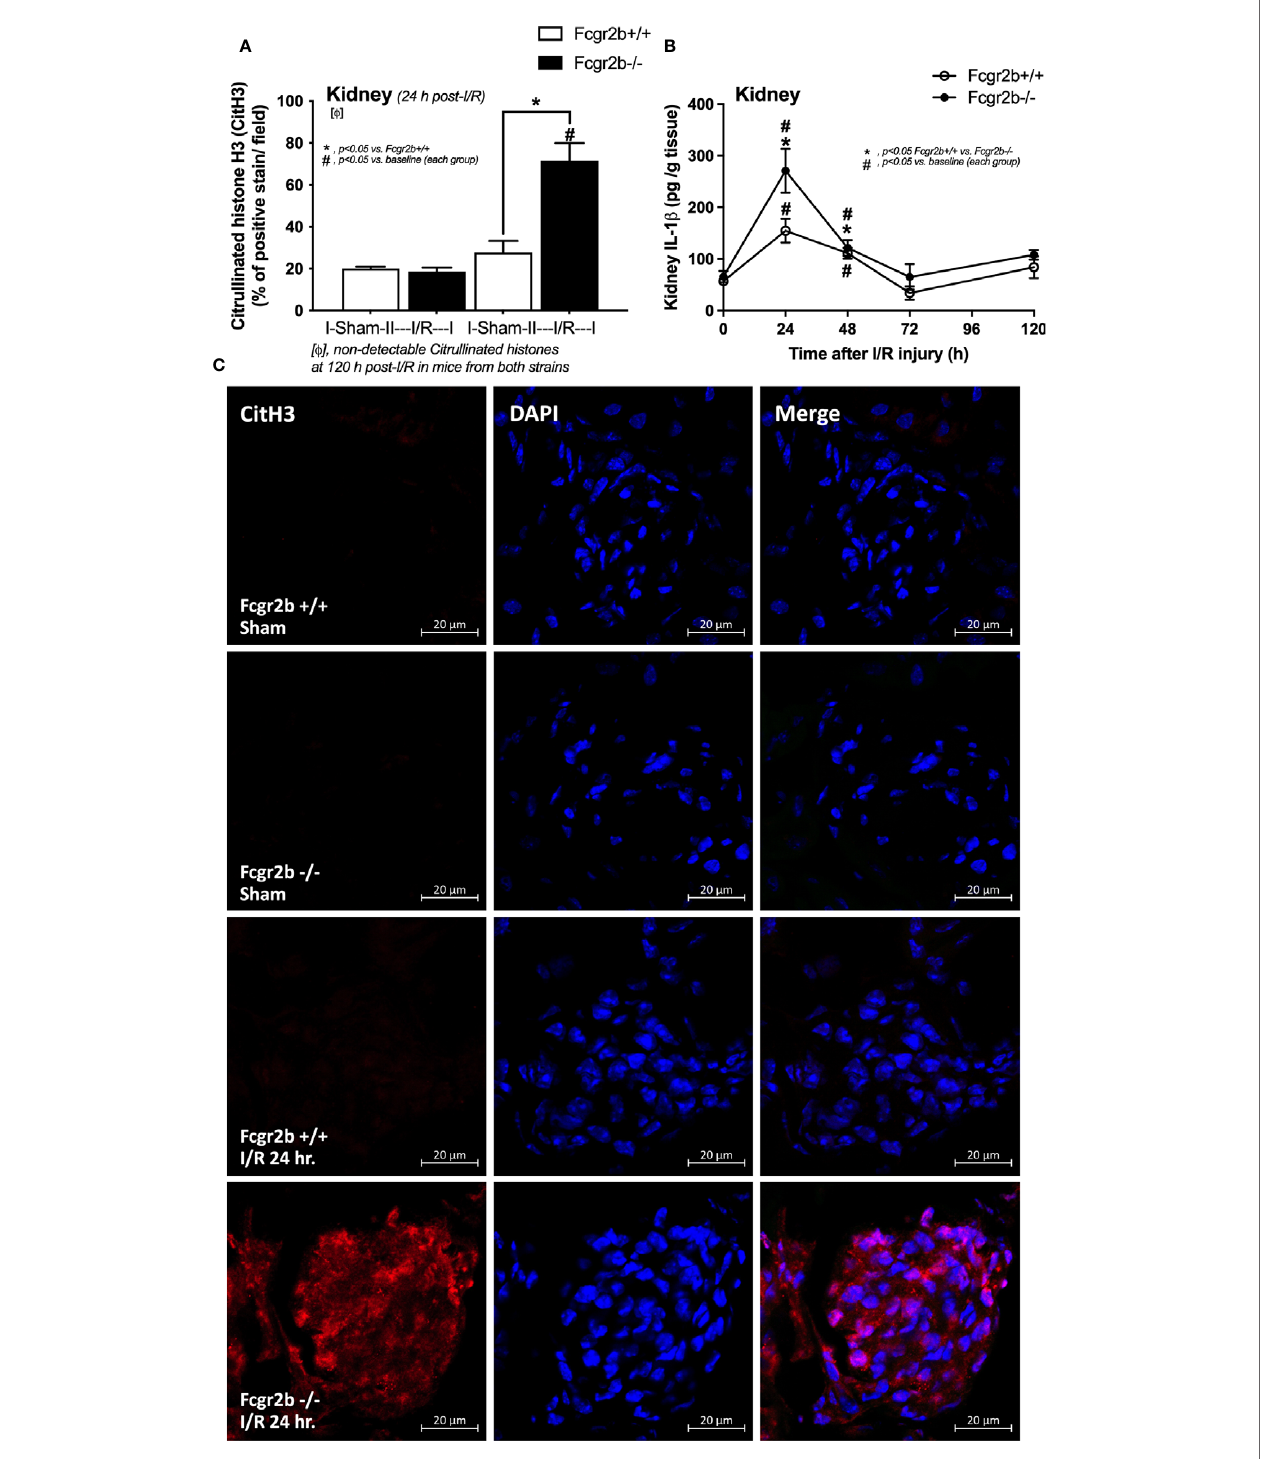
FIGURE 4 | Renal ischemia reperfusion injury (I/R) at 24 h induced more prominent neutrophil extracellular traps (NETs) in renal glomeruli of lupus prone mice. Characteristics of NETs in kidneys from Fcgr2b-/- mice or wild-type (Fcgr2b+/+) mice after renal ischemia reperfusion injury (I/R) as determined by immuno fl uorescent staining of citrullinated histone H3 (CitH3) at 24 h post-I/R (A) (n = 5 – 6/group) and IL-1 b from renal tissue (B) (n = 5 – 6/time-point) with the representative immuno fl uorescent pictures of CitH3 (red) and 4 ’ ,6-diamidino-2-phenylindole (DAPI, blue nuclear staining) at 24 h post-I/R (or sham) (original magni fi cation 630x) (C) are